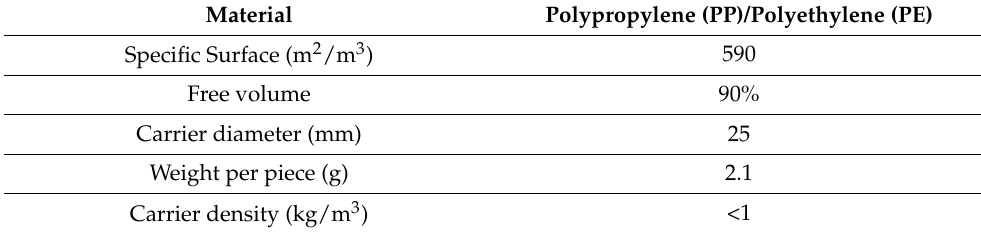
Table 2. Carriers characteristics of the MBBR system.